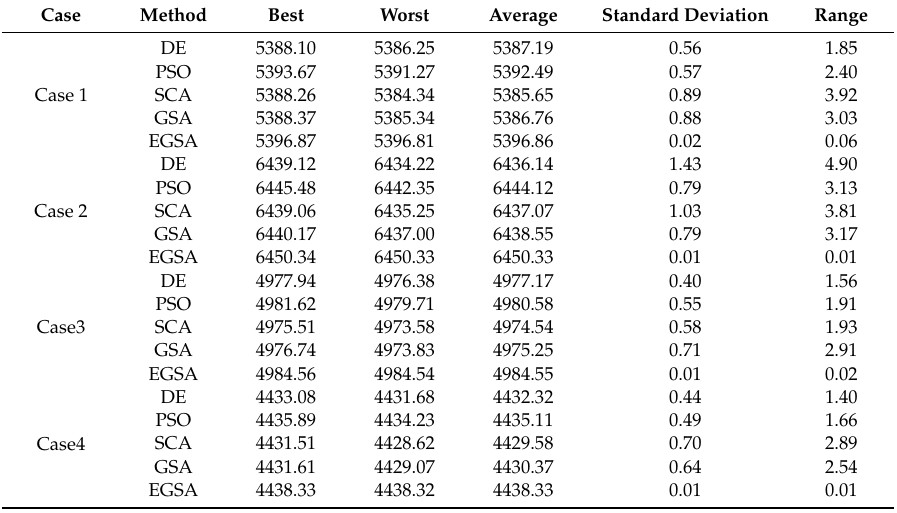
Table 5. Statistical results of the 5 methods in 20 independent runs for 4 cases of power generation (10 4 kW·h).